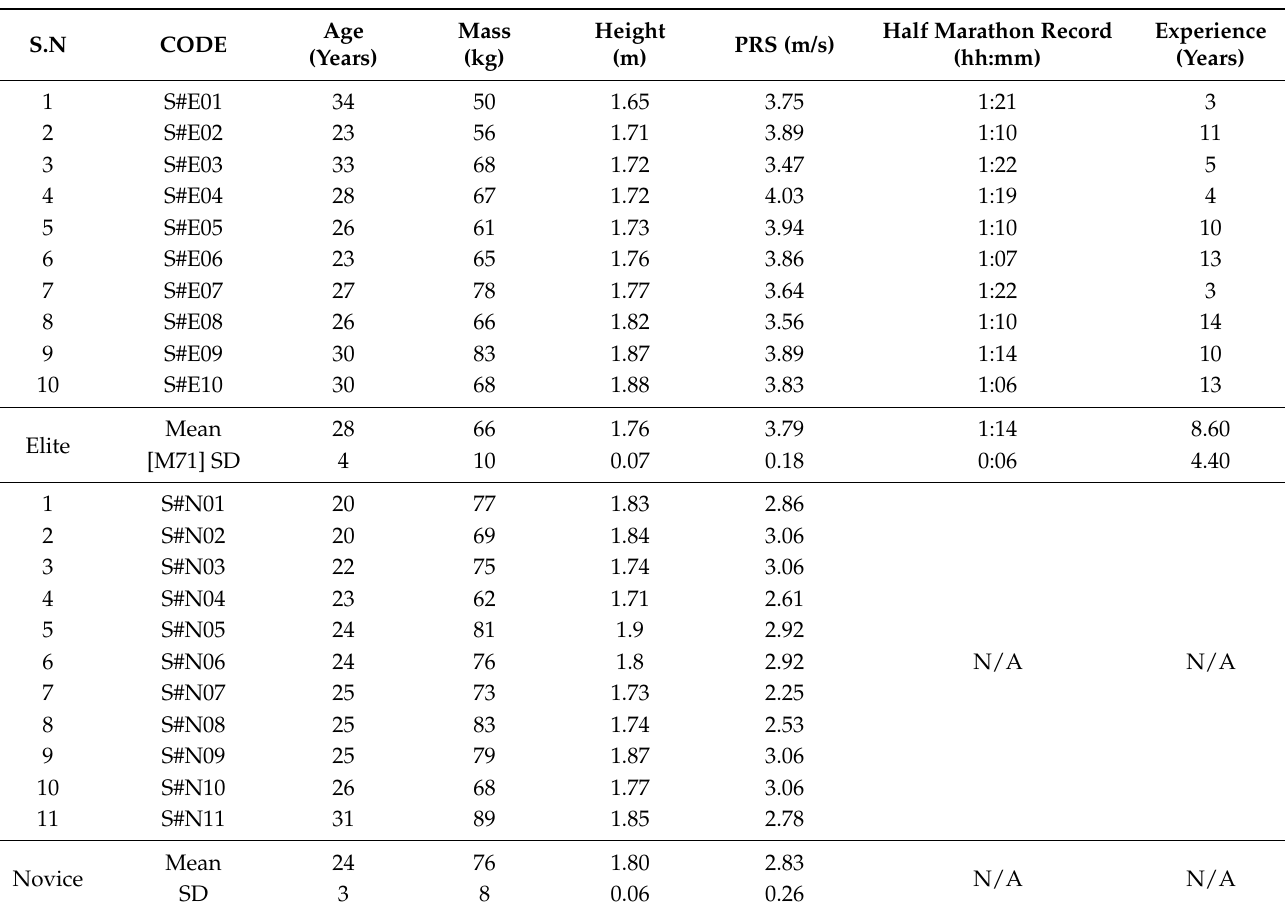
Table A1. Descriptive information of each